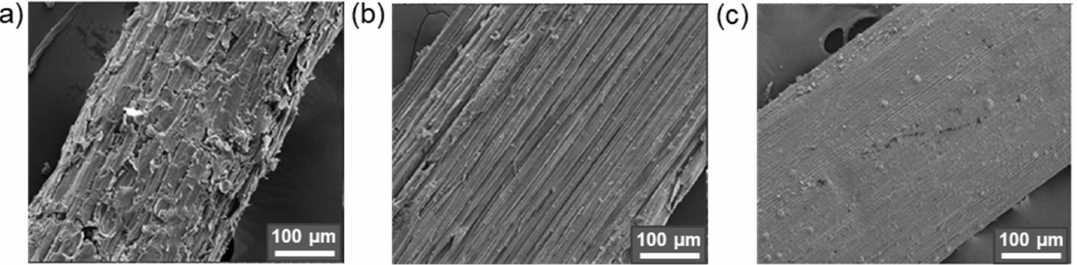
Figure 8. SEM images of untreated cellulose fibers ( a ), treated by 10 wt% NaOH solution ( b ) and treated by 10 wt% NaOH solution and 2 wt% of APTES ( c ) (reproduced from [172] with permission of John Wiley &